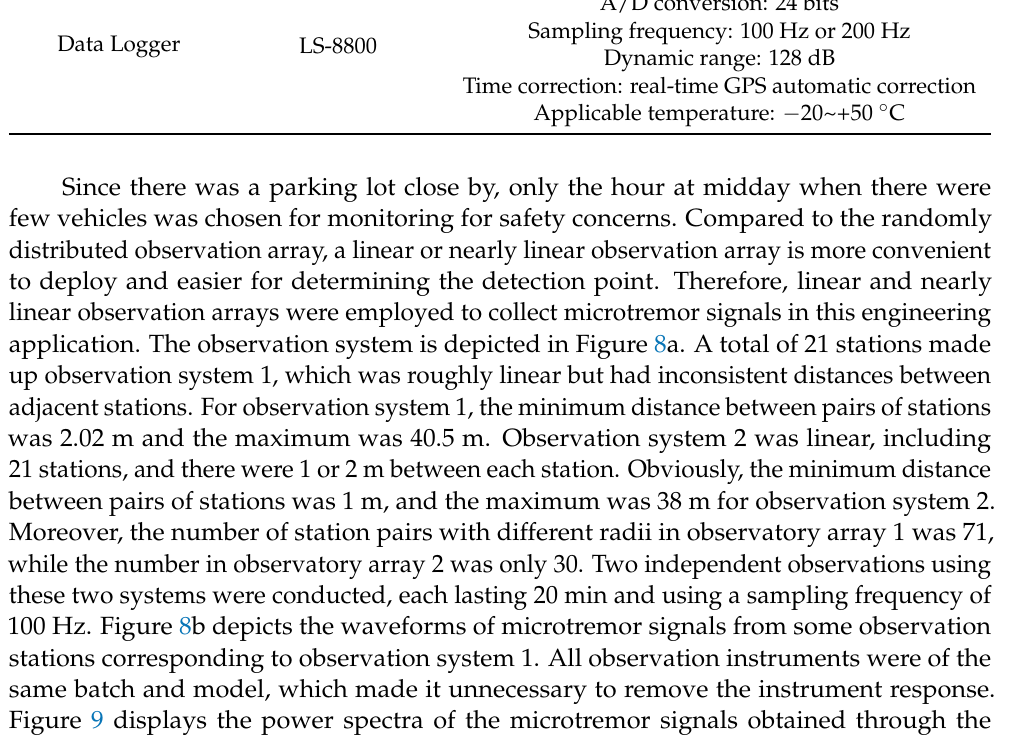
Table 5. The main performance indicators of independent microtremor detectors.